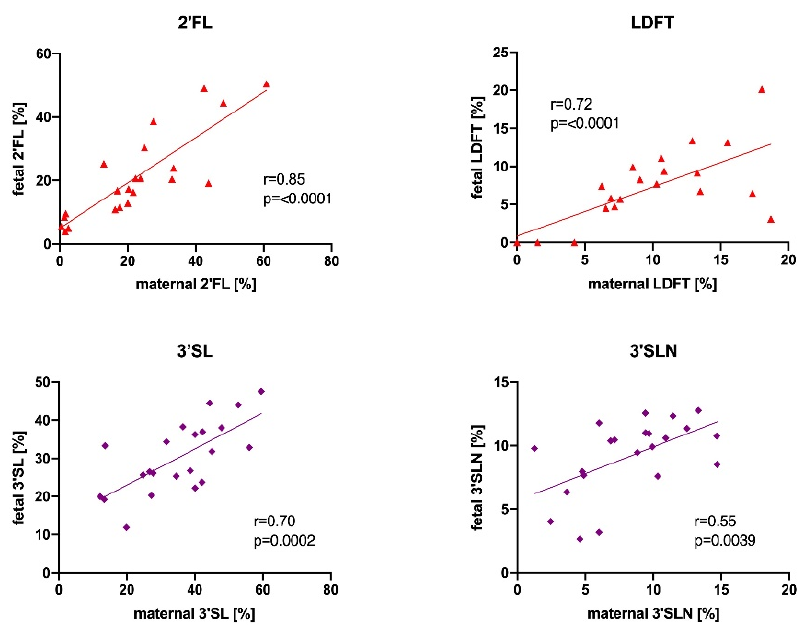
Figure 3. Relative HMO concentration in maternal serum peripartum correlate with fetal HMOs in cord blood. Scatter plots with Pearson correlation are shown for 2 ′ -fucosyllactose (2 ′ FL), lactodifucotetraose (LDFT), 3 ′ -sialyllactose (3 ′ SL), 3 ′ -siallyllactosamine (3 ′ SLN) ( n = 22).